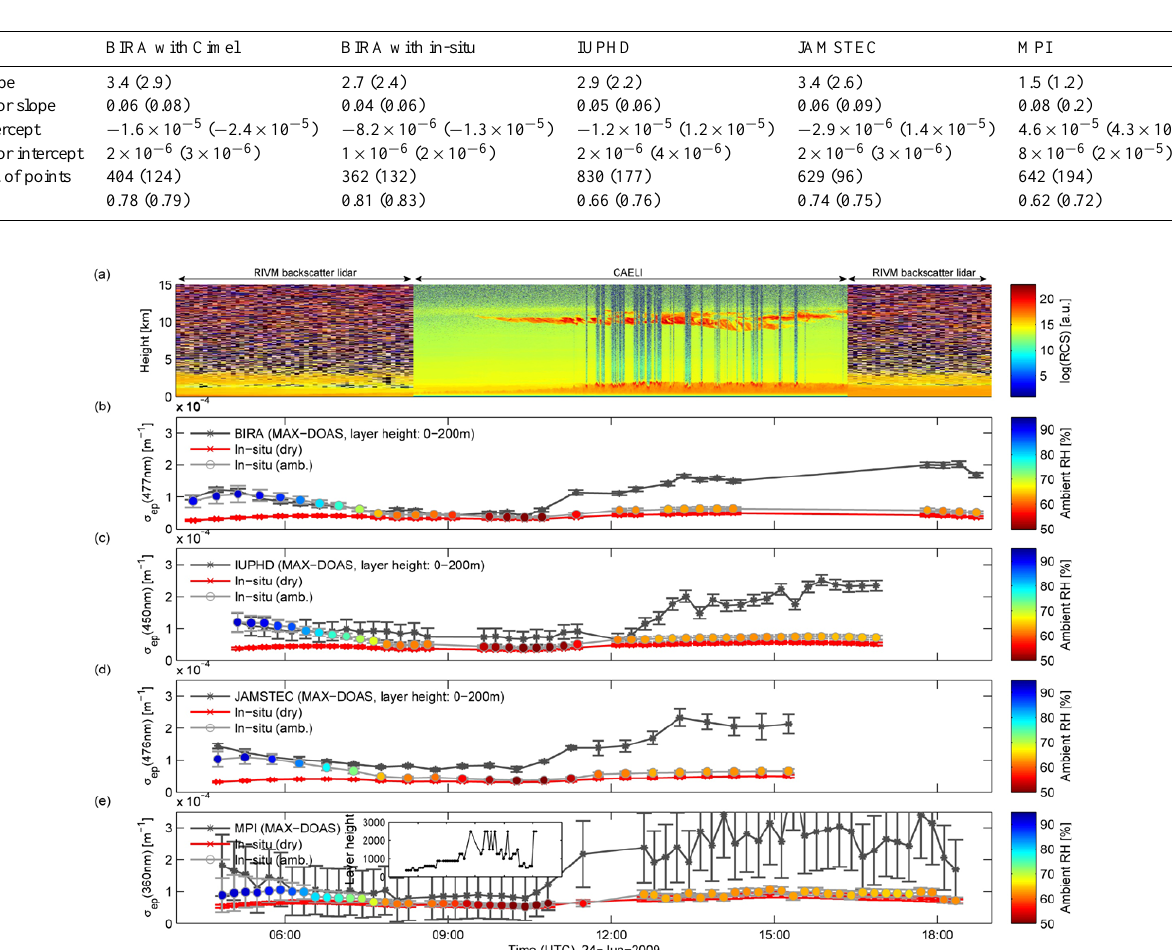
Table 2. Results of an orthogonal linear regression (using weights) between ambient in-situ and MAX-DOAS extinction coefficients for the time periods given in Table 1. Values in parenthesis are for time periods when all four MAX-DOAS instruments were measuring in parallel.